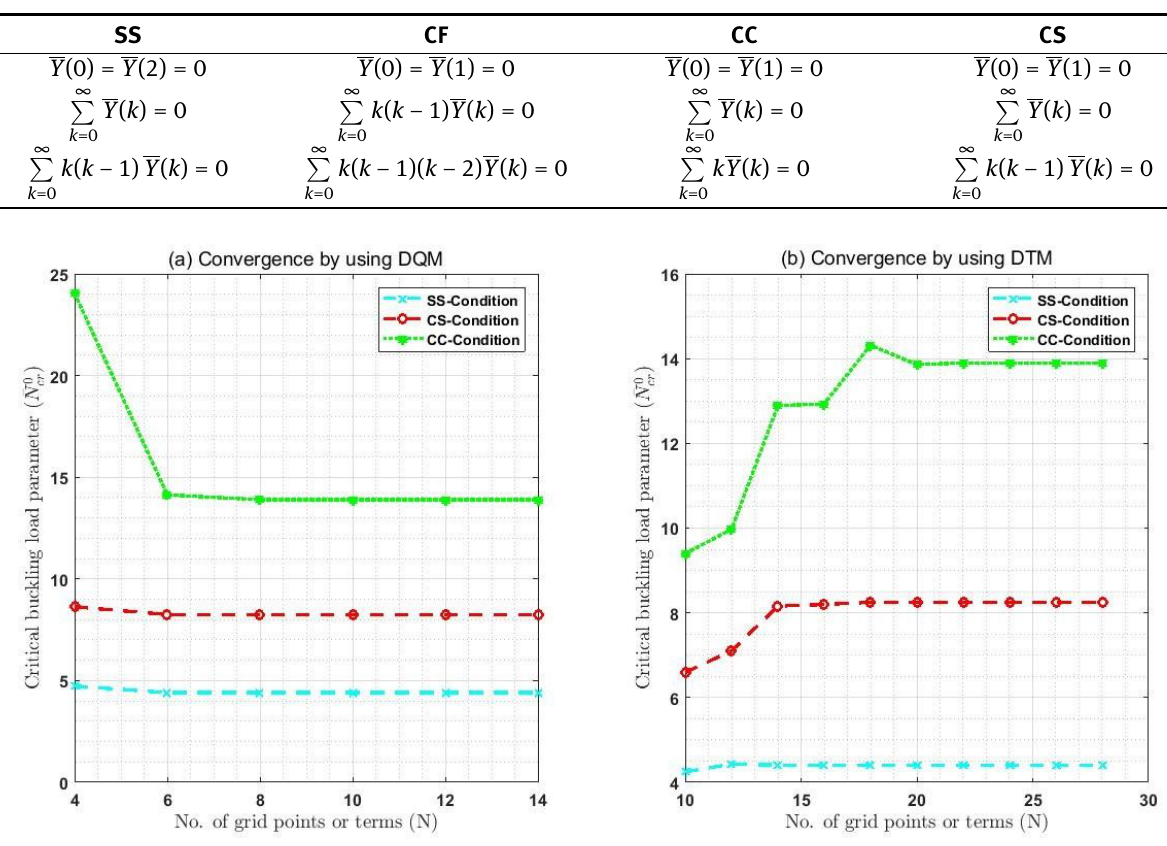
For Y (2) ≠ 0, Y (3) ≠ 0, the eigenvalue problem may